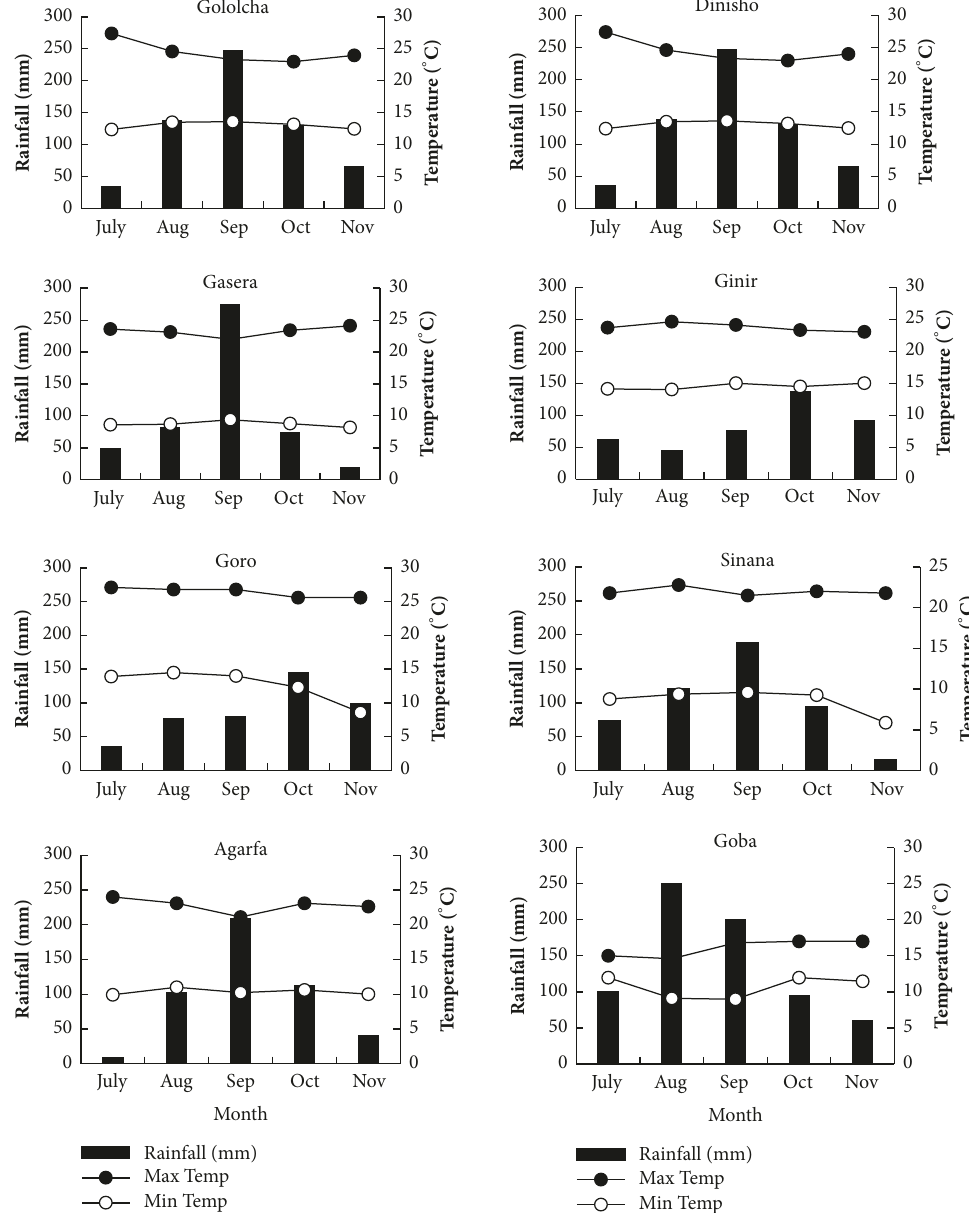
Figure 2: Monthly rainfall in bars and monthly minimum and maximum temperature (curves) during main cropping season (July–November) in 2017 in eight surveyed districts in Bale highlands.